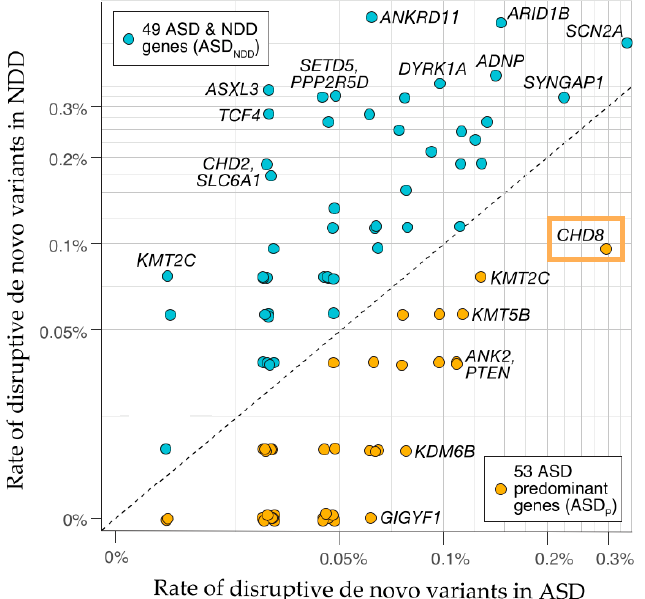
Figure 1. The frequency of disruptive de novo variants, including protein truncation variants and missense variants with an MPC (missense badness, PolyPhen-2, constraint) score ≥ 1 in autism spectrum disorder (ASD)-ascertained and neurodevelopmental delay (NDD)-ascertained cohorts is shown for the 102-associated genes. Fifty-three genes (orange circles) with a higher frequency in ASD are designated ASD-predominant (ASD P ), while 49 genes with a higher frequency in NDD (light blue circles) are designated NDD-predominant (NDD P ). The high confidence risk gene CHD8 (chromodomain helicase domain 8), boxed in orange, top-ranks among ASD-predominant genes. Graphic adapted from [8], attribution license 5004260244019.